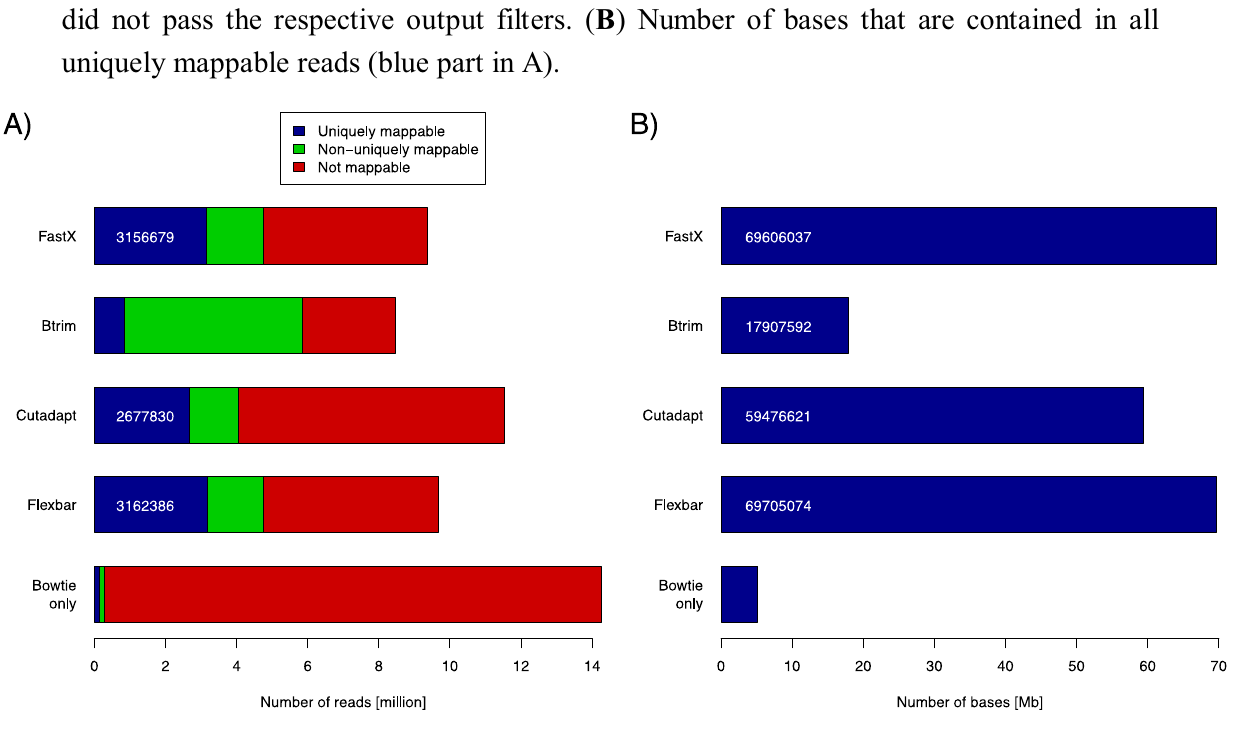
Figure 3 . Compute time and memory requirements for FLEXBAR and competitors in (cid:69)(cid:72)(cid:81)(cid:70)(cid:75)(cid:80)(cid:68)(cid:85)(cid:78)(cid:3)(cid:20)(cid:17)(cid:3)(cid:41)(cid:47)(cid:40)(cid:59)(cid:37)(cid:36)(cid:53)(cid:182)(cid:86)(cid:3)(cid:83)(cid:72)(cid:85)(cid:73)(cid:82)(cid:85)(cid:80)(cid:68)(cid:81)(cid:70)(cid:72)(cid:3)(cid:76)(cid:86)(cid:3)(cid:79)(cid:76)(cid:86)(cid:87)(cid:72)(cid:71)(cid:3)(cid:73)(cid:82)(cid:85)(cid:3)(cid:20)(cid:15) 2 and 4 threads. The evaluation